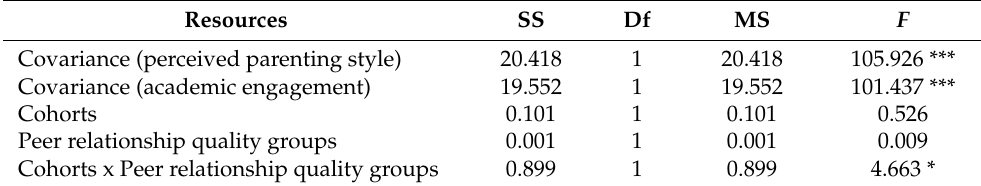
Table 6. Two-way ANCOVA for life satisfaction by cohorts and peer relationship quality groups (upper-middle and high).